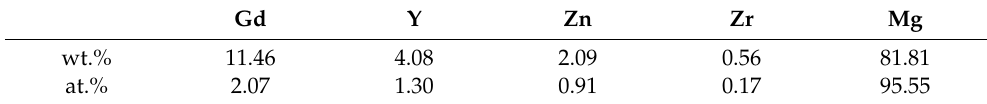
Table 1. Chemical compositions of the studied Mg-Gd-Y-Zn-Zr alloy. Gd Y Zn Zr Mg wt.% 11.46 4.08 2.09 0.56 81.81 at.% 2.07 1.30 0.91 0.17